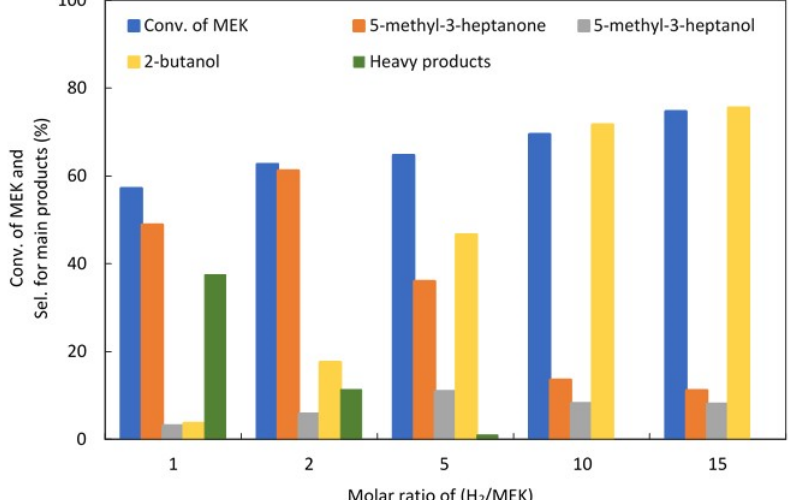
Figure 5. Catalytic results for the conversion of MEK to the main products with different H 2 /MEK molar ratios. Reaction conditions: catalyst weight, 1.0 g (15% Cu–ZrO 2 ); feed rate of MEK, 1.0 mL/h; reaction temperature, 180 ◦ C; space time, 89 g mol − 1 h. Heavy products include C 12 ketone, C 12 alcohol, condensation products, and so